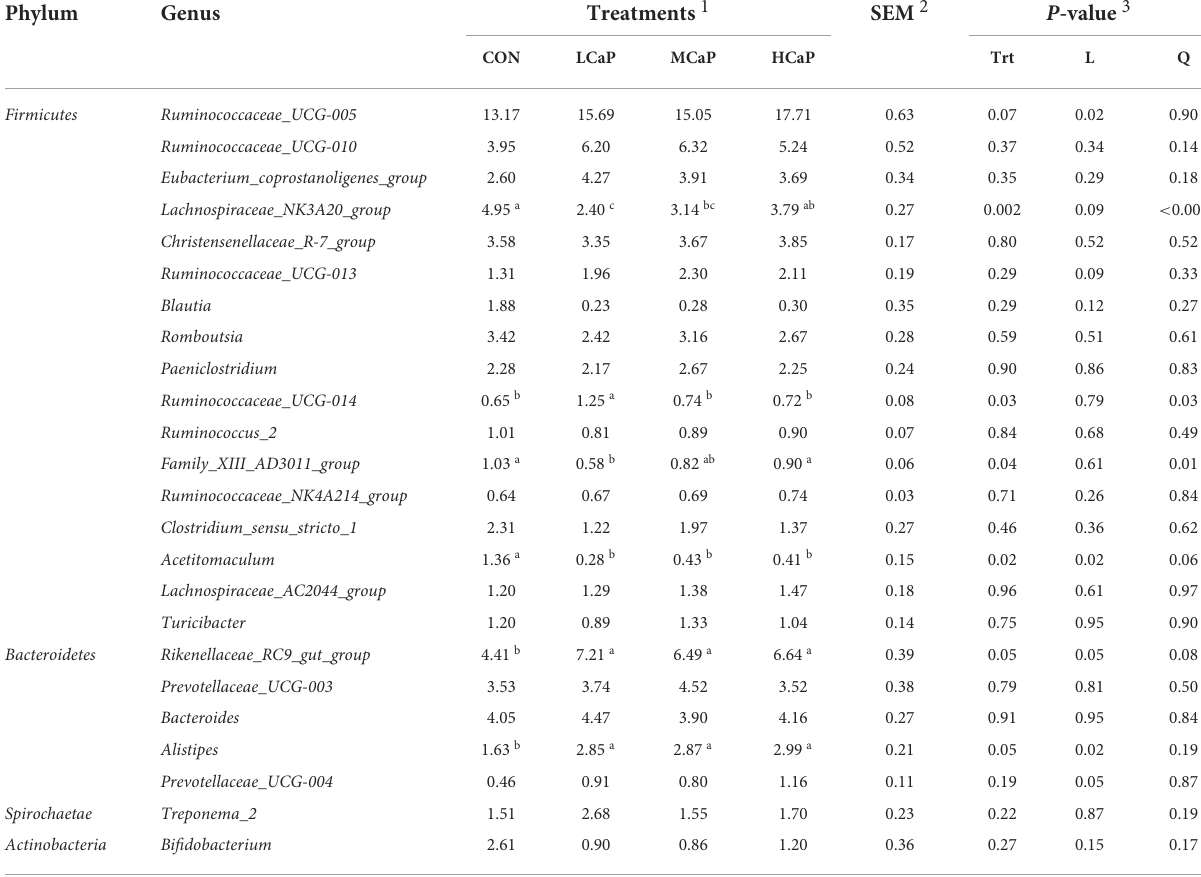
TABLE 4 Effects of calcium propionate feeding levels on relative abundance (%) of major fecal bacterial communities at the genus level (averagely accounting for ≥ 0.5% of the total sequences in at least one treatment) of dairy cows in early lactation.